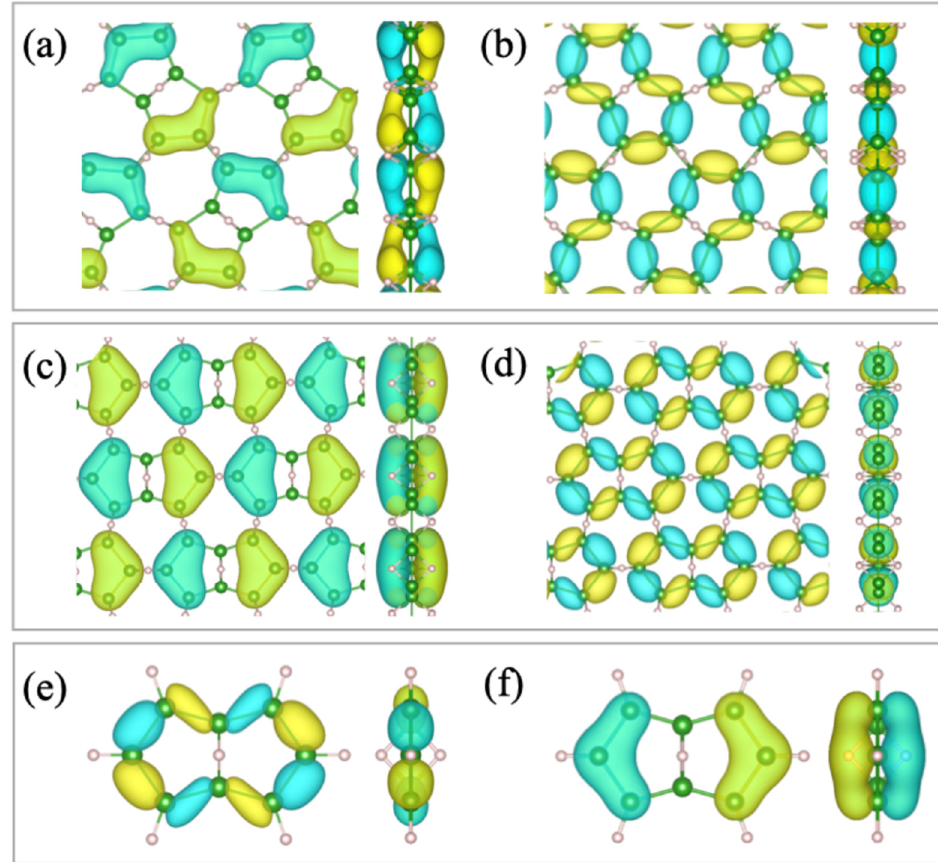
Figure 4. Atomic structures of the borophane layer ( α 1 , β 1 ), and the molecule (2:3:4:6:7:8:-H-1,5:1,5- µ H-B 8 H 8 ). Wave functions and molecular orbitals at Г point are schematically overlapped in the atomic models. ( a ) Lower and ( b ) higher bands of a Dirac nodal loop of the α 1 -borophane [15,17]. ( c ) Lower and ( d ) higher bands of a Dirac nodal loop of the β 1 -borophane (see Appendix A). ( e ) HOMO and ( f ) LUMO of the 2:3:4:6:7:8:-H-1,5:1,5- µ H-B 8 H 8 molecule. The color of each molecular orbital corresponds to the sign of its wave